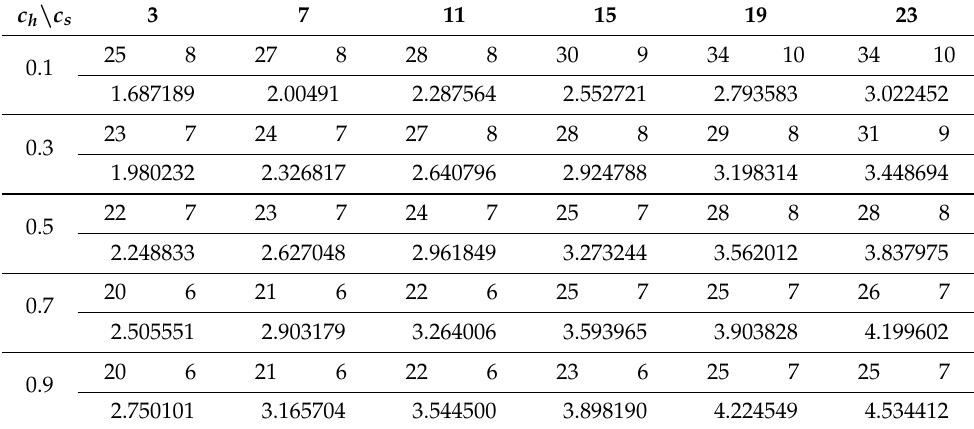
Table 2. Total expected cost c h vs. c s